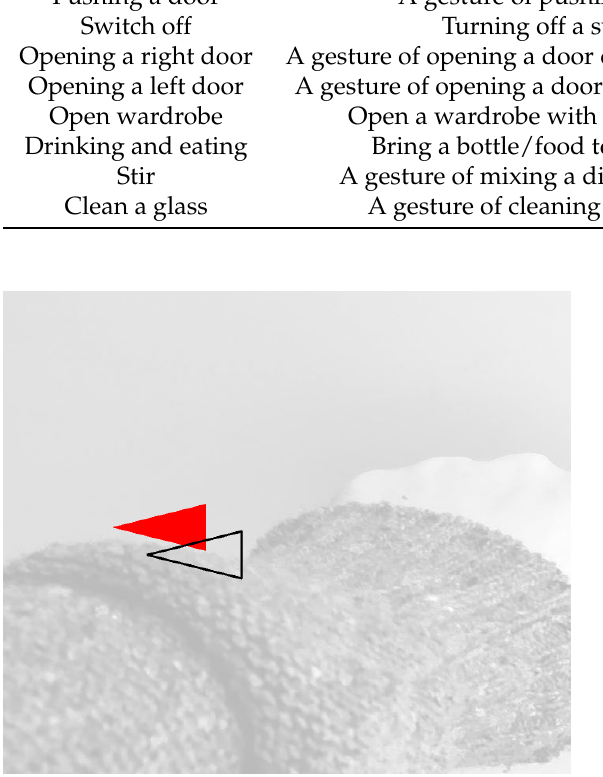
Figure 3. The key-point marked with red and the cursor drawn using black